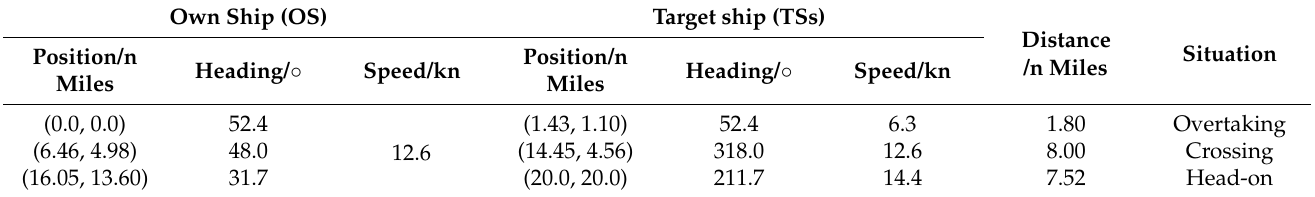
Table 2. Parameters and encounter situation between OS and TSs.